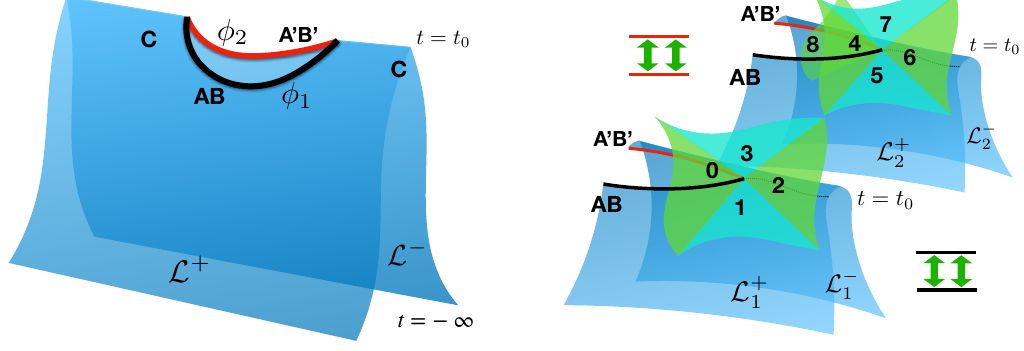
(cid:30) 1 Figure 19 . Left: density matrices element [ (cid:26) de(cid:12)ned by path-integral on Schwinger- AB ( t 0 )] (cid:30) 2 Keldysh two-folds . Right: norm of the operator state ( t 0 ) as a path-integral over two L (cid:6) N Schwinger-Keldysh contours (i.e. four time-folds (cid:6) 1 ; 2 ) glued as shown by the green arrows. The lo- L cal singularity arising from the gluing is demonstrated by the structure of Rindler wedges, indexed by m = 0 ; : : : ; 8. The index can be understood as the imaginary part of the local Rindler time ds 2 = r 2 d(cid:28) 2 + dr 2 + d! i d! i near @ ( AB ): Im (cid:28) = m(cid:25) . Identifying m = 0 and m = 8 puts the 2 (cid:0) local Rindler temperature at T Rindler = 1 = 4 (cid:25)